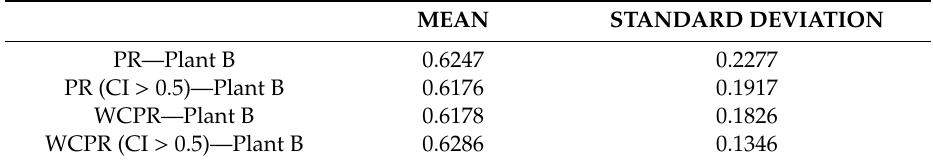
Table 3. Mean and standard deviation values of PR, PR (CI > 0.5), WCPR, WCPR (CI > 0.5)—Plant B.